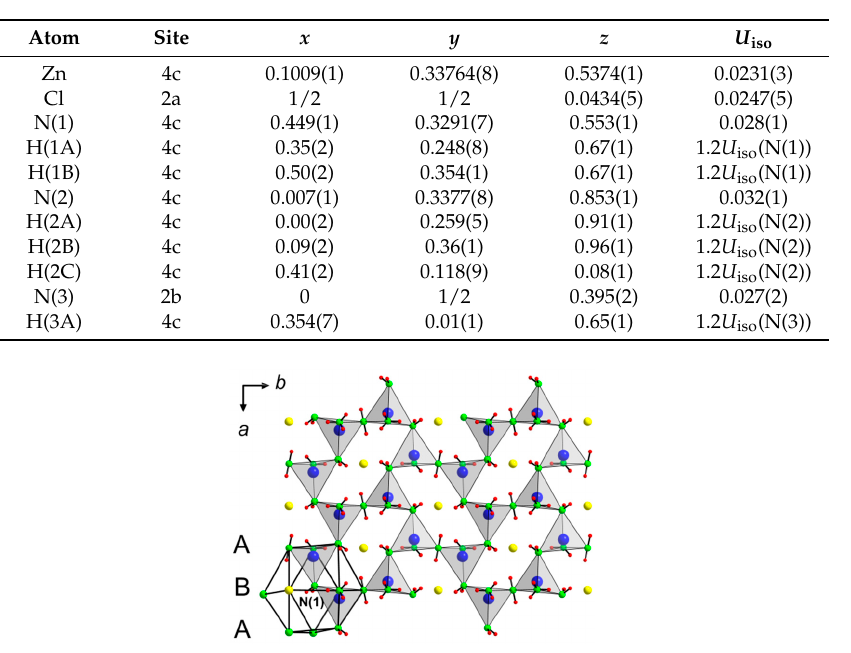
(cid:104) Zn ( NH 3 )( NH 2 ) 3/21/2 +